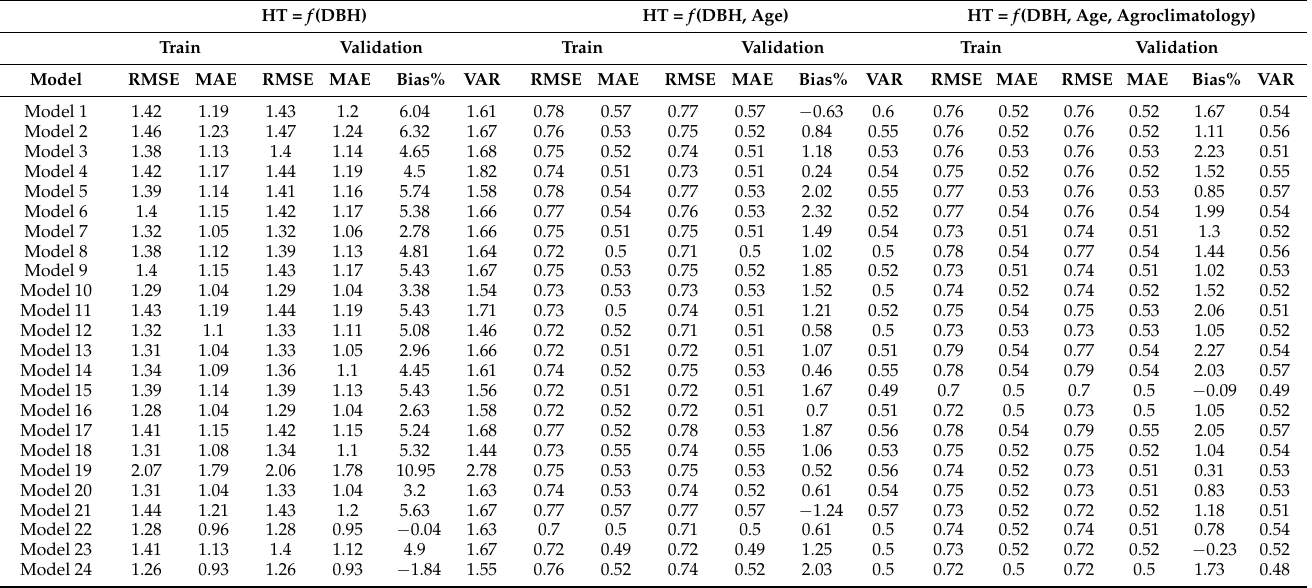
Table 3. Performance of the statistics of each model trained and function evaluated, both for training and for validation in the total height predictions of the Guazuma crinita Mart. in the Peruvian Amazon. HT = f (DBH) HT = f (DBH,